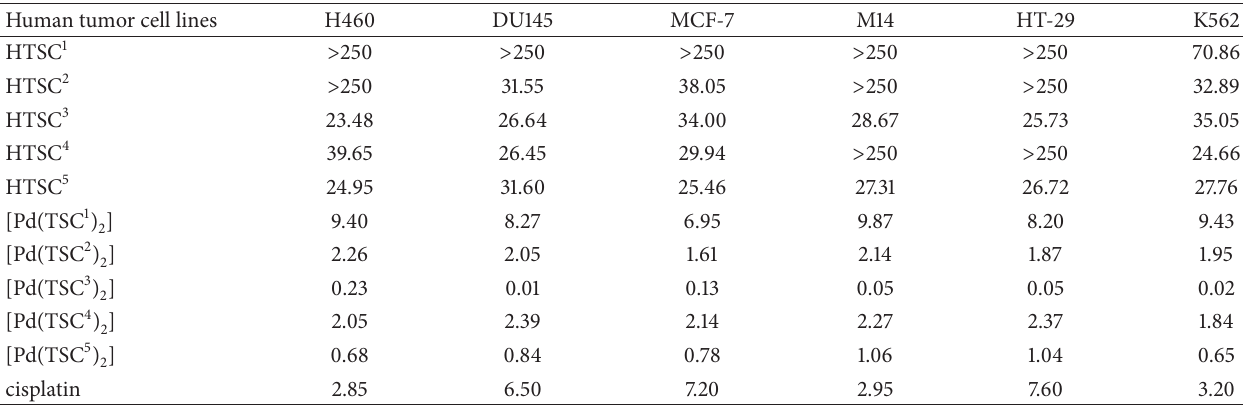
] , and cisplatin against the different human tumor 2